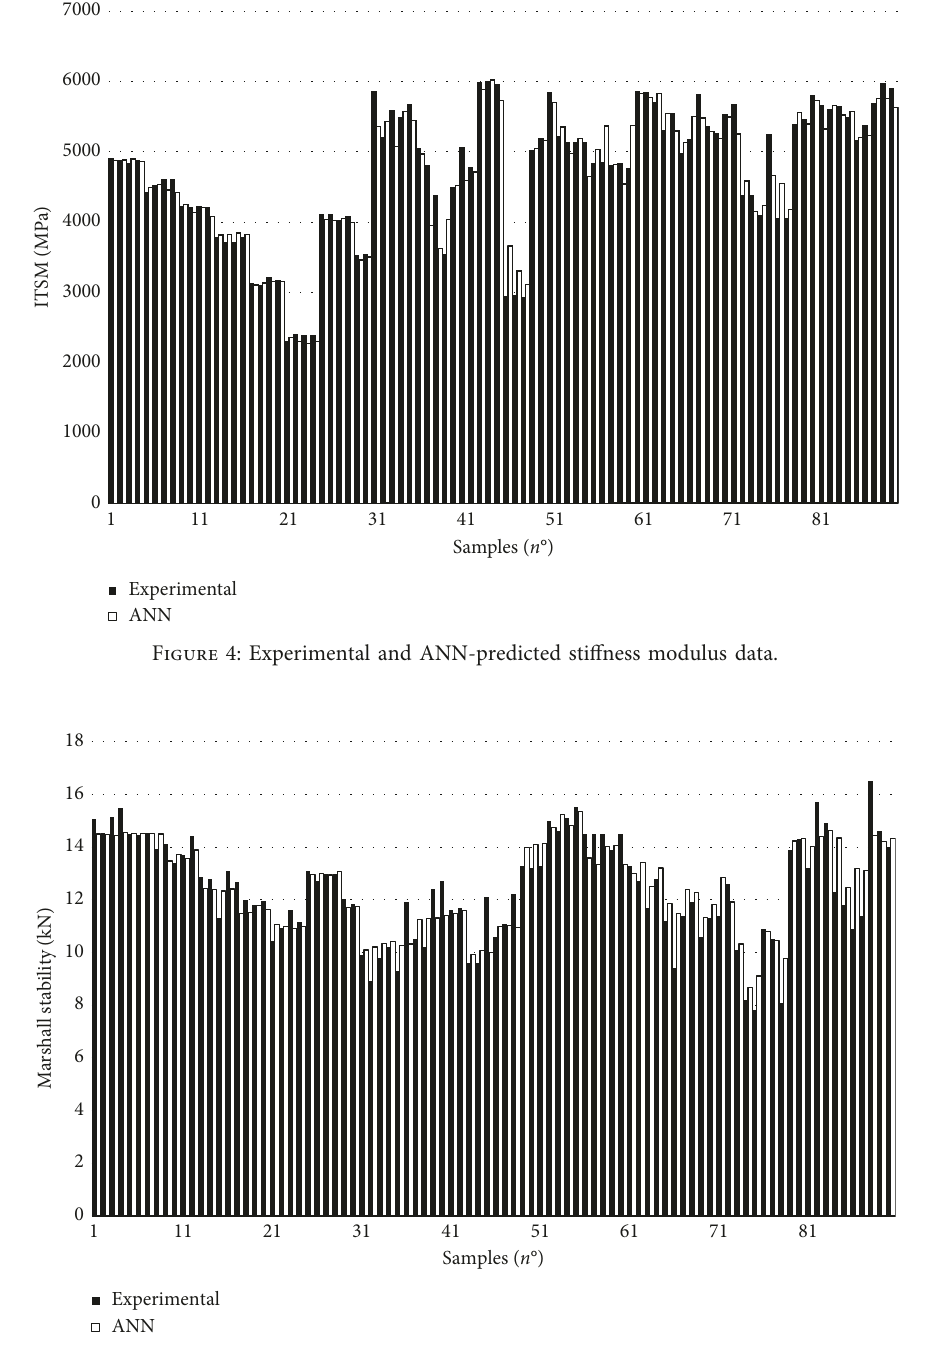
Figure 5: Experimental and ANN-predicted Marshall stability